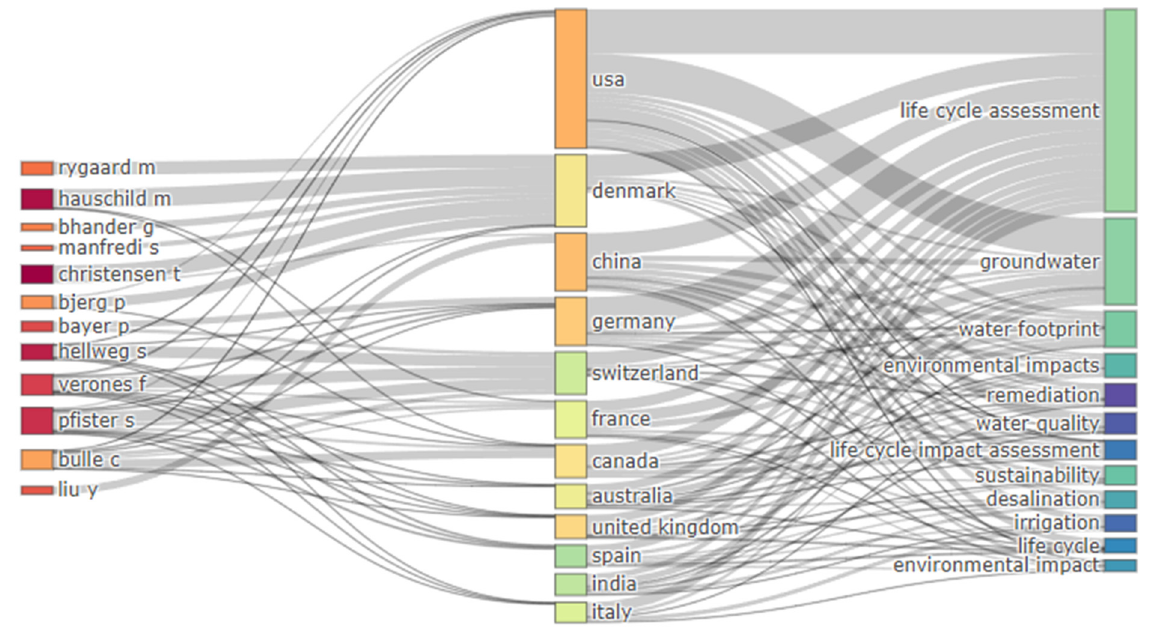
Figure 8. Three-fields plot (author, country, keyword). Documents: 306 documents only from Scopus and 158 from WoS and 316 from both databases.